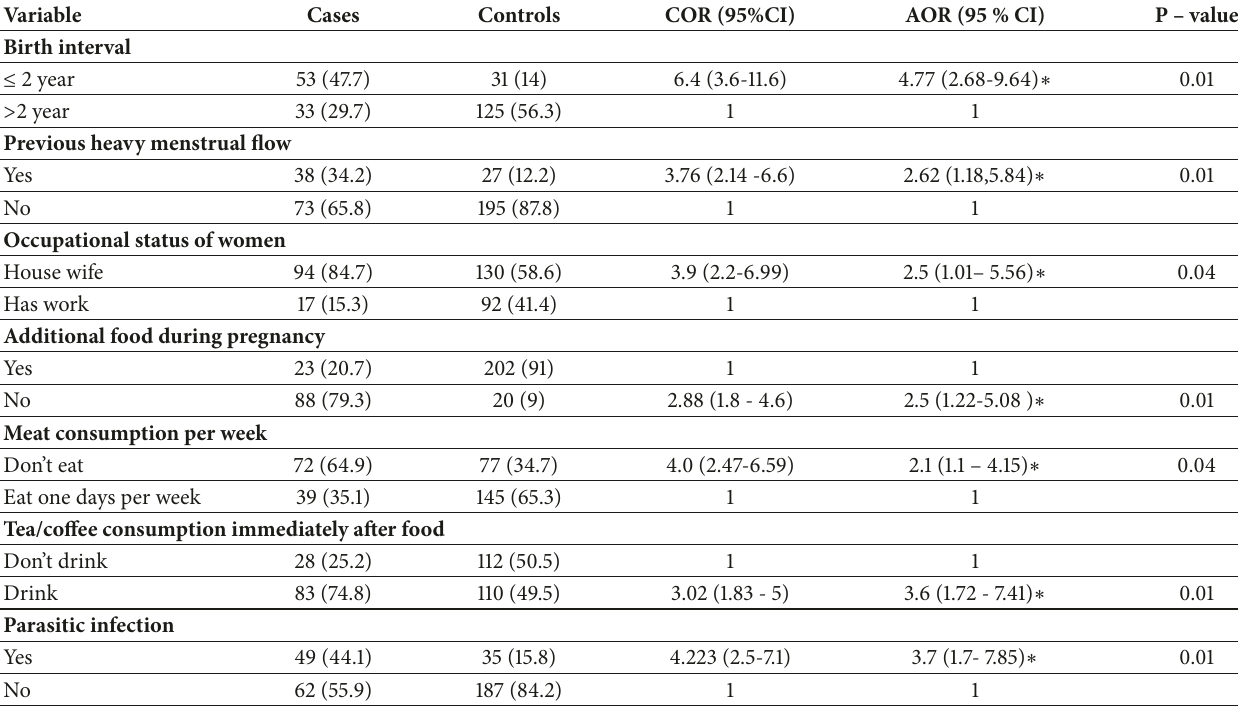
Table 5: Determinants of anemia among pregnant mothers attending ANC in public health facilities of Durame Town, February to May 2017.